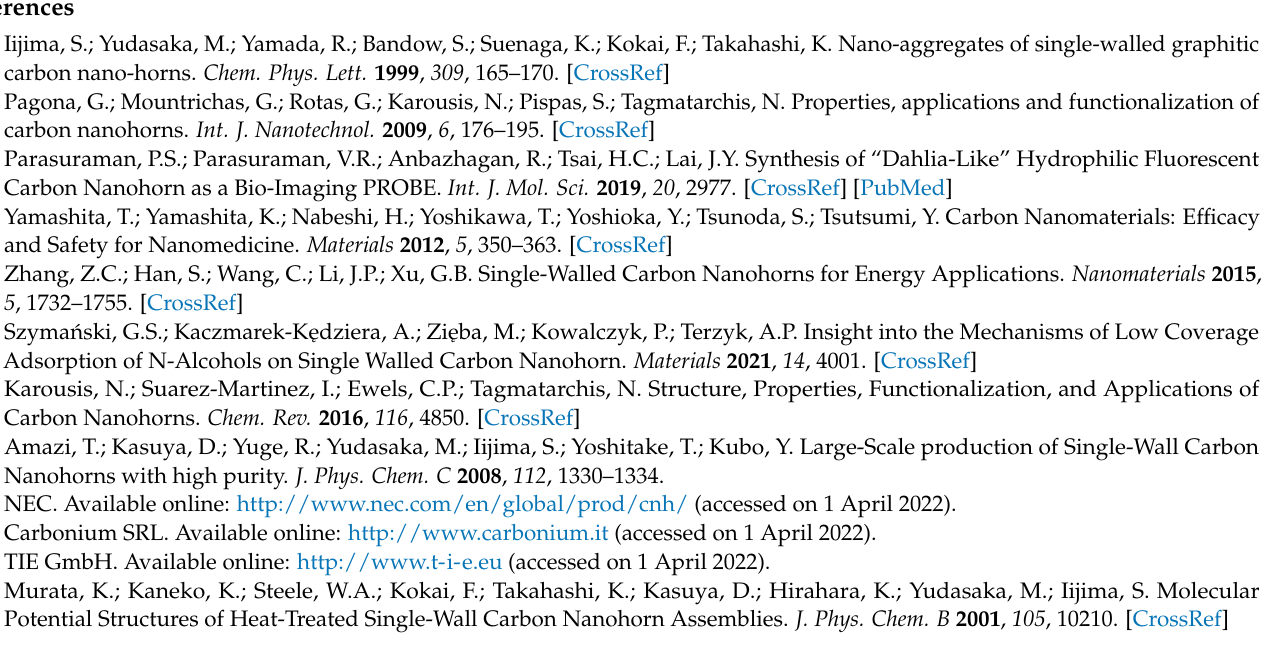
and E0 = 0.2 kV (e), and a dark-field transmitted electron detector (STEM-DF) at E0 = 30 kV (f); Figure S2: High-resolution scanning electron microscopy micrographs of the SCNB8 sample using the upper (secondary electrons, a, c, and e) and top (energy-filtered backscattered electrons, b, d, and f) in-lens detectors at E0 = 0.5 kV; Figure S3: High-resolution scanning electron microscopy micrographs of the SCNA9 sample using the upper (secondary electrons, a, c, and e) and top (energy-filtered backscattered electrons, b, and d) in-lens detectors at E0 = 0.5 kV, and a dark-field transmitted electron detector (STEM-DF) at E0 = 30 kV (f); Figure S4: High-resolution scanning electron microscopy micrographs of the SCNB9 sample using the upper (secondary electrons, a, c, e, and f) and top (energy-filtered backscattered electrons, b and d) in-lens detectors at E0 = 0.5 kV.; Figure S5: Elemental X-Ray map of SCNA9 sample in STEM mode at E0 = 20 kV; Table S1: Elemental Analysis (EDS) from the Bulk of the Carbon